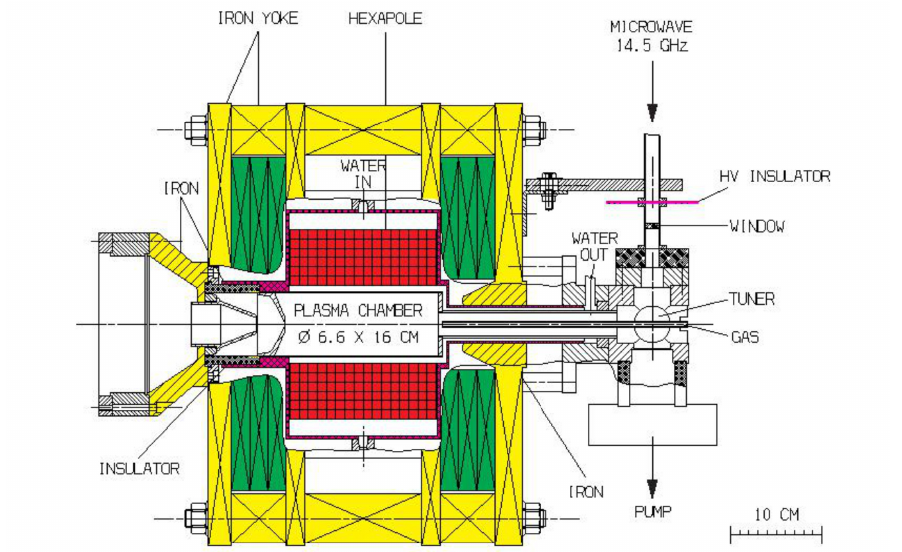
Figure 1. The Caprice ECRIS. Normal conducting coils (shown in green) together with a permanent magnet hexapole (shown in red). Microwave power is fed to the source from a high power generator at 14.5GHz, connected by a wave guide to the ECRIS. The bias voltage needs to be isolated from the microwave. Iron parts in yellow. Extraction is to the left; here, a simple diode system is shown. Gas is injected from the side opposite to the extraction